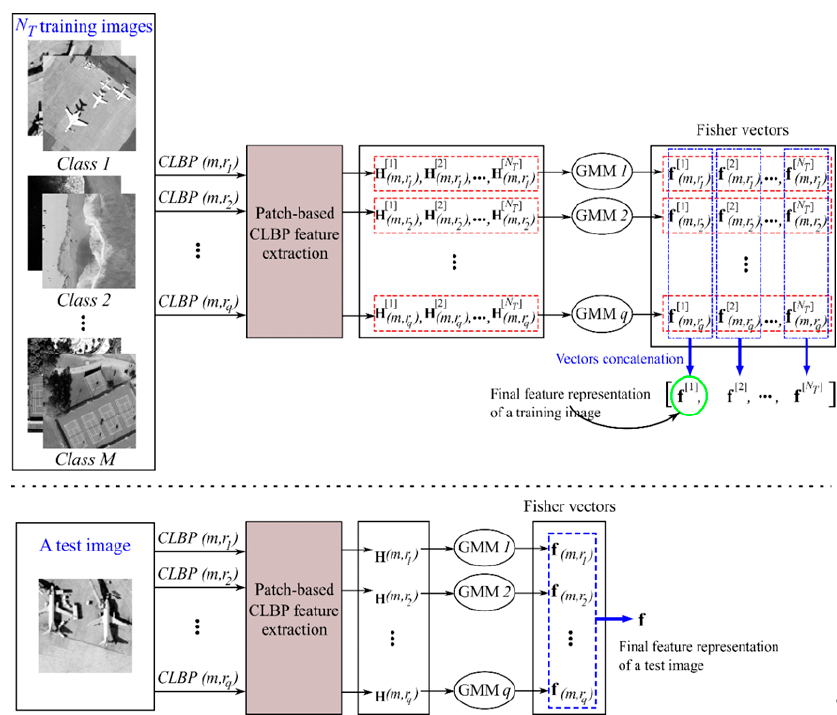
Figure 6. Fisher vector representation.